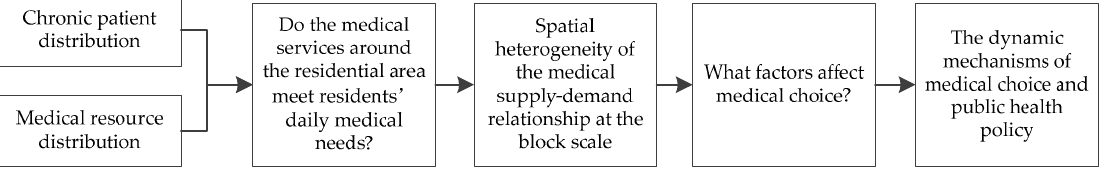
Figure 1. Overall research framework.